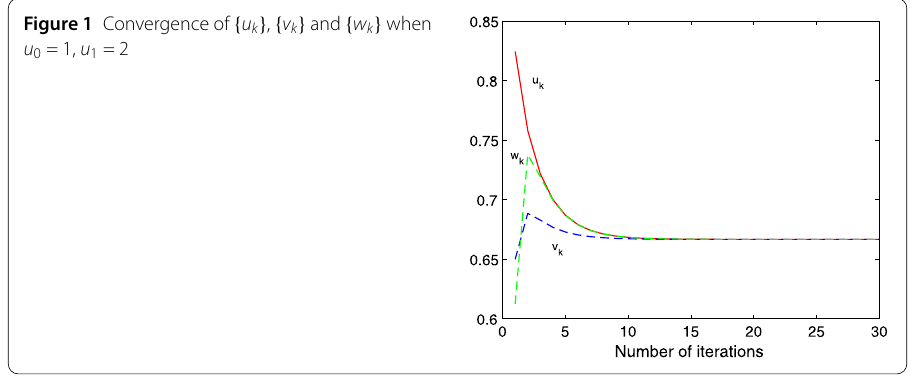
Figure 1 Convergence of { u k } , { v k } and { w k } when